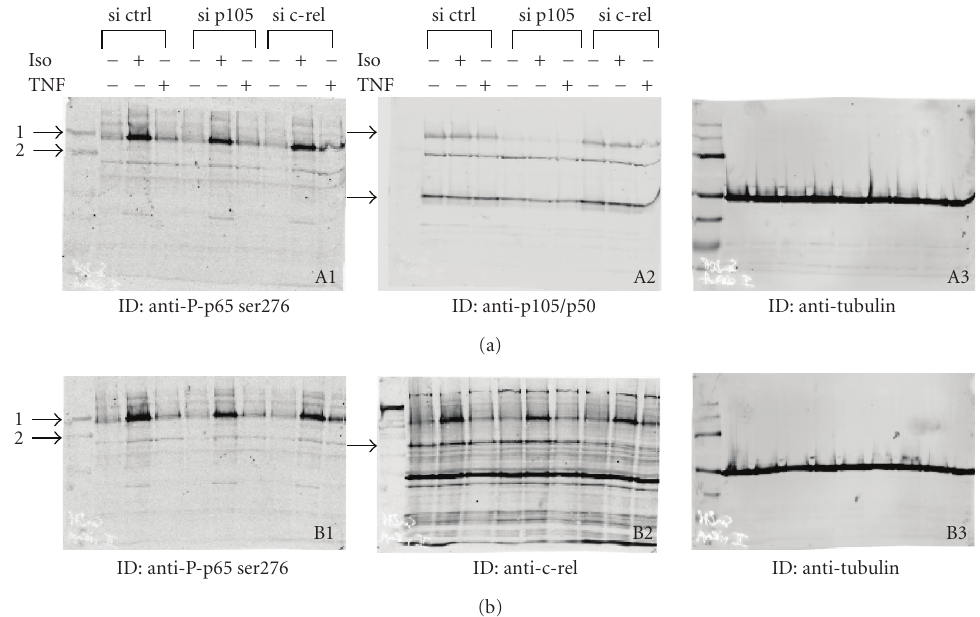
Figure 5: The detected 130 kDa and 80 kDa immunoreactivities are not NF- κ B p105/p50 or c-Rel. 1321N1 cells were transiently transfected with control, p105/p50 or c-Rel siRNA as described in Section 2. Cells were induced for 30 min with TNF- α (2000IU/mL) or iso (10 μ M). Presence of Ser276-phosphorylated p65 in cell lysates was analysed by Western Blot using Cell Signaling no. 3037 (A1, B1). 130 and 80 kDa immunoreactivities are indicated by arrows (1 and 2 resp.). Because of the overlap of the 130kDa and the p105 immunoreactive bands, blot A was first stripped and reprobed with anti-p105/p50 (A2). p105 immunoreactivity is indicated by the upper arrow; p50 immunoreactivity is indicated by the lower arrow. Blot B was extensively washed and reprobed (without stripping) with anti-c-Rel (B2). c-Rel immunoreactivity is indicated by an arrow. Tubulin was used as a loading control (A3,